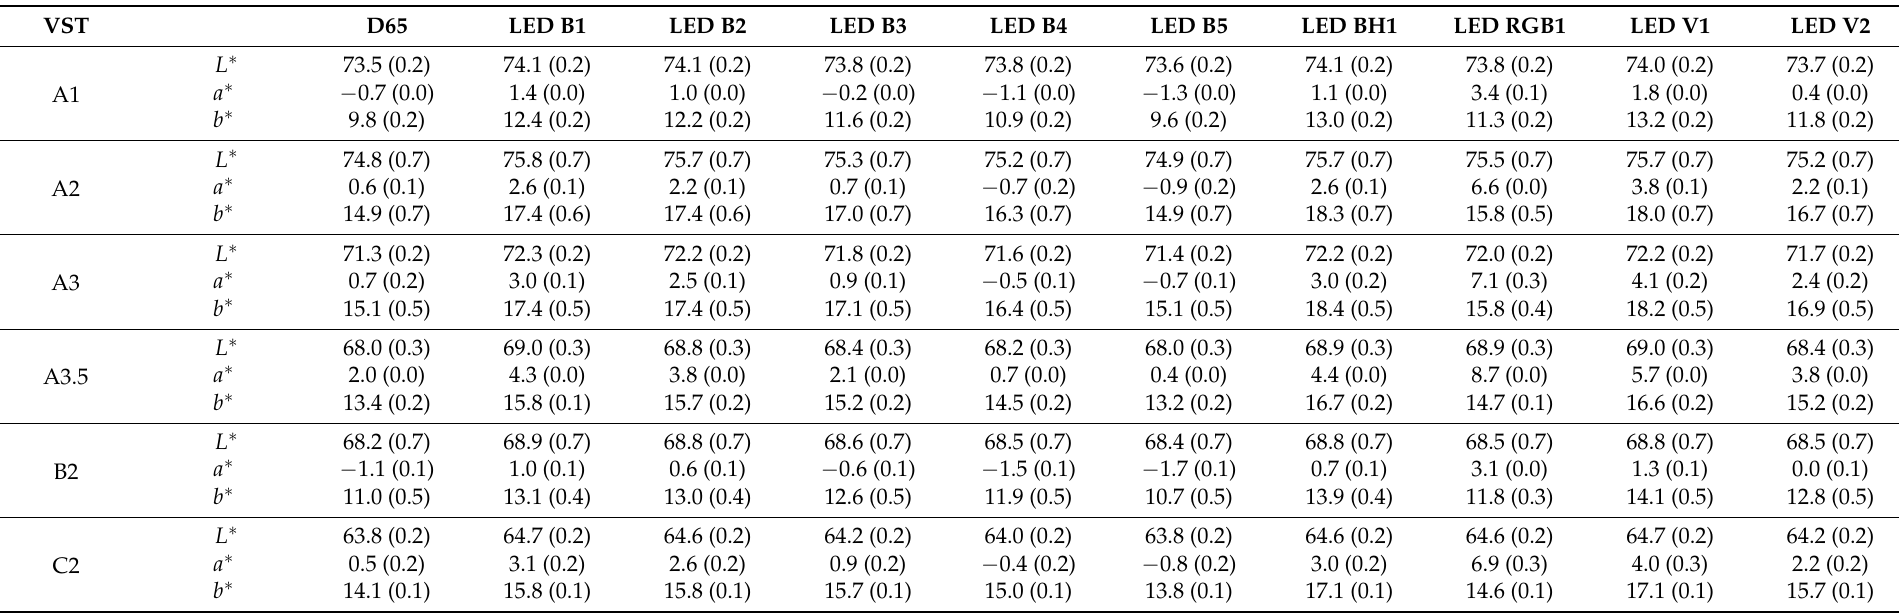
Table 2. Mean CIELAB color coordinate values and standard deviations (in parentheses) for the VST ceramic shades under D65 and nine LED illuminants (corresponding colors under D65 illuminant and CIE 1931 standard colorimetric